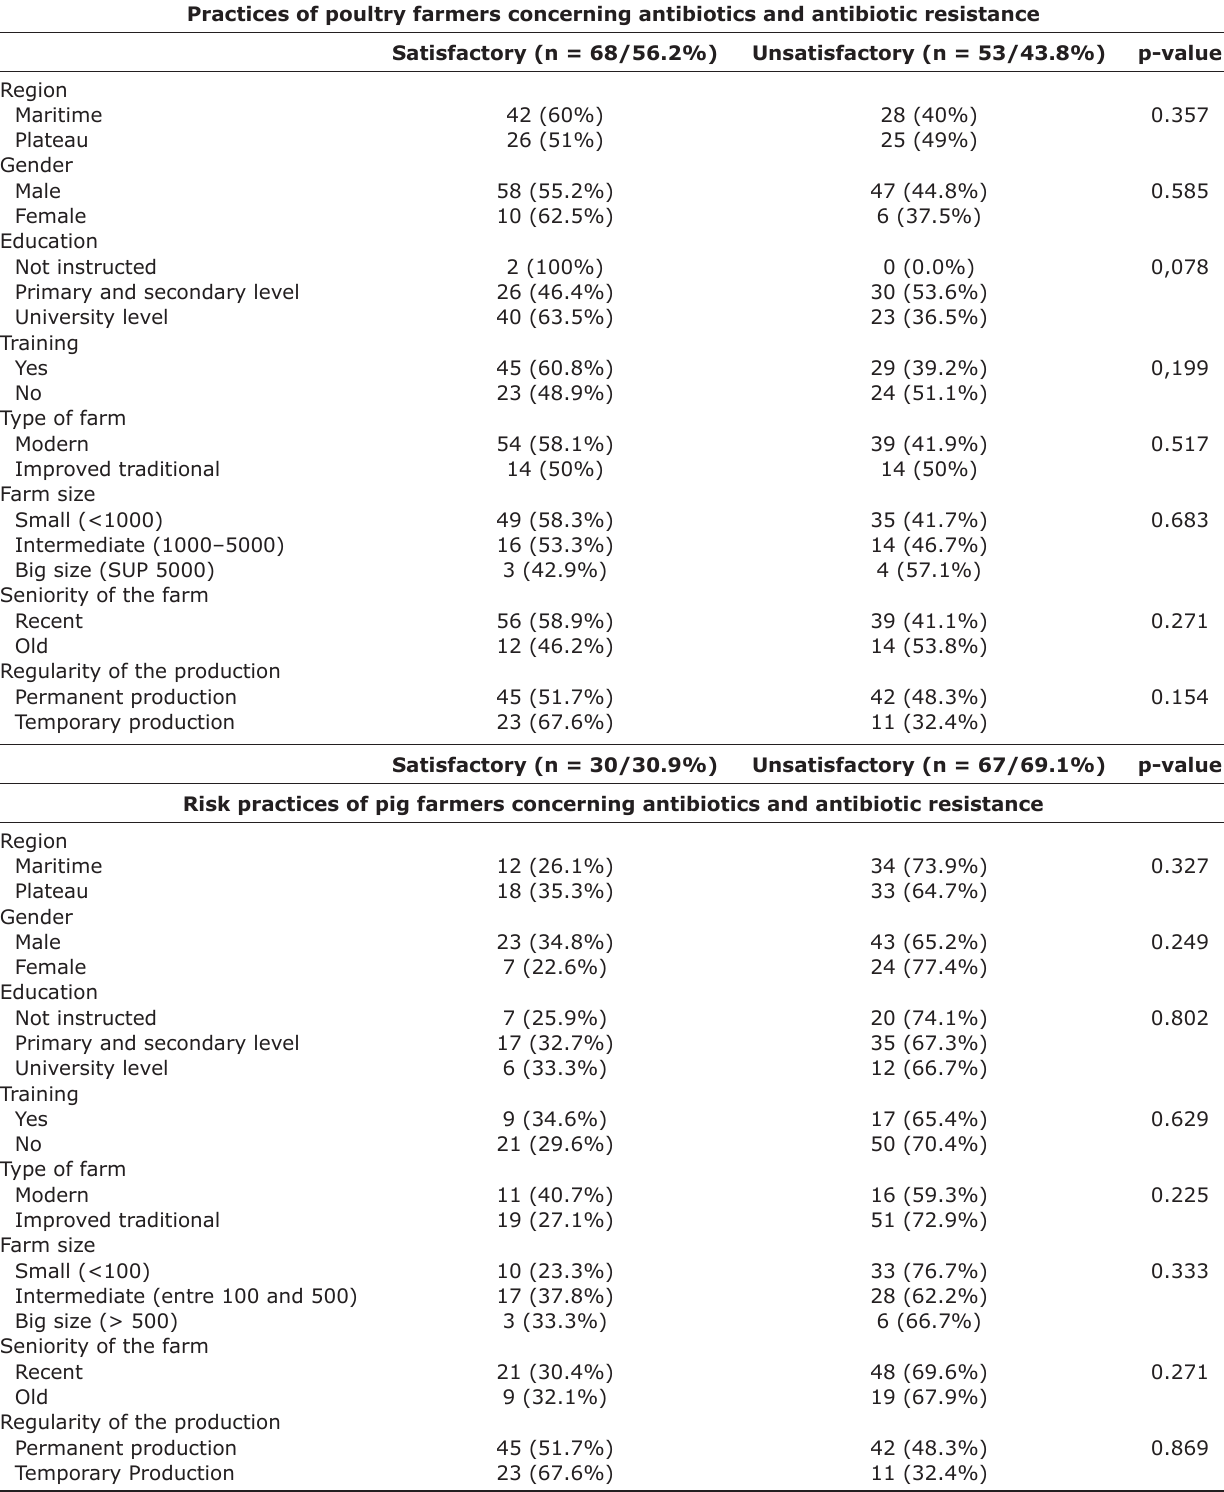
Table-5: Practices of poultry and pig farmers concerning antibiotics and antibiotic resistance. Practices of poultry farmers concerning antibiotics and antibiotic resistance Satisfactory (n =